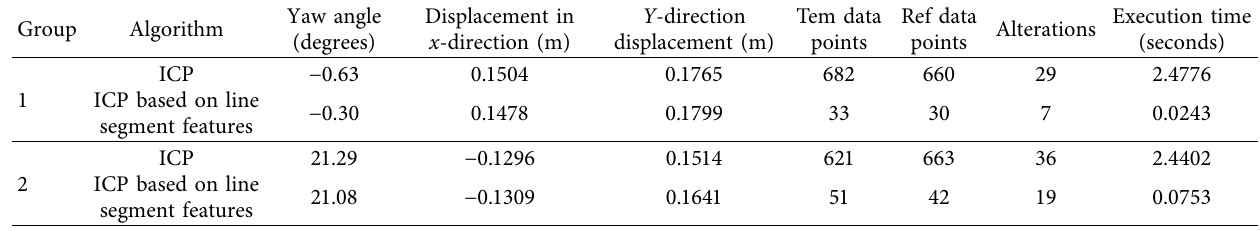
Figure 12: ICP experimental results based on line segment characteristics (the second group). (a) Common ICP methods. (b) Line based ICP methods. Table 3: ICP experimental results based on line segment characteristics.